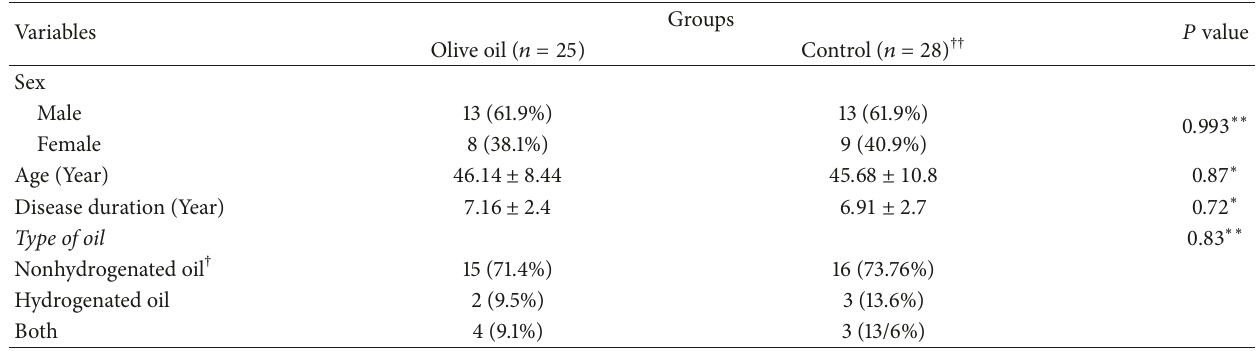
Table 1: Demographic characteristics of the study